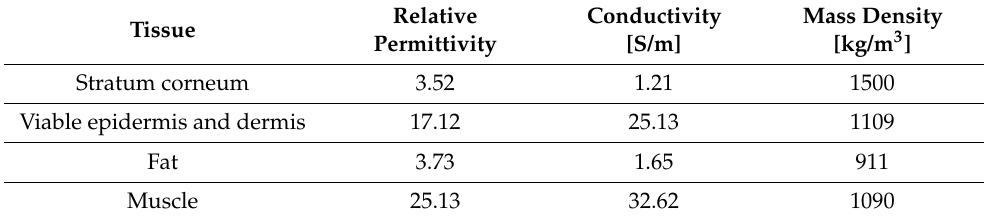
Table 2. Dielectric properties of the different skin